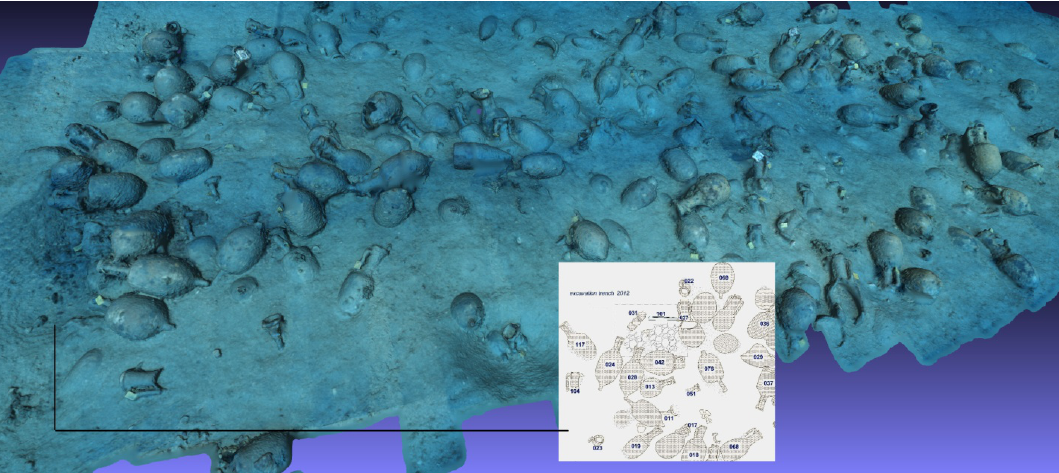
Figure 8: 3D textured model and detail of the 2012 excavation trench of Shipwreck N.24, © H.I.M.A., E. Diamanti